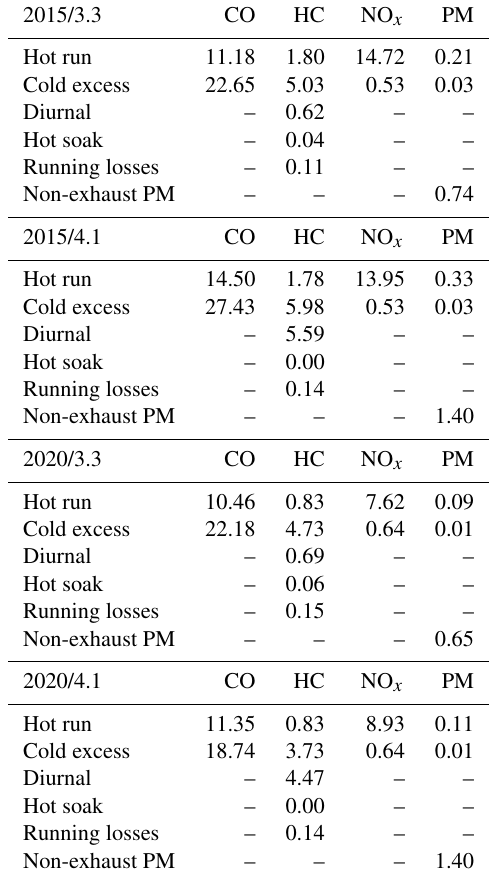
Table 7. Breakdown of aggregate emissions [td − 1 ] by emission type for each Yeti run case (fleet composition year/HBEFA